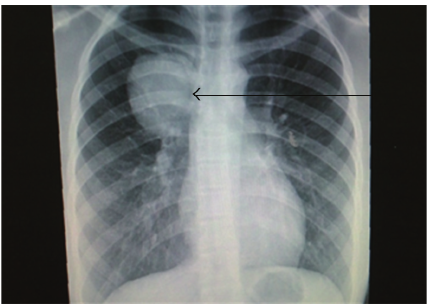
Figure 1: Posteroanterior radiograph of chest showing (arrow) right-sided circumscribed mass in the upper lobe close to the hilum.